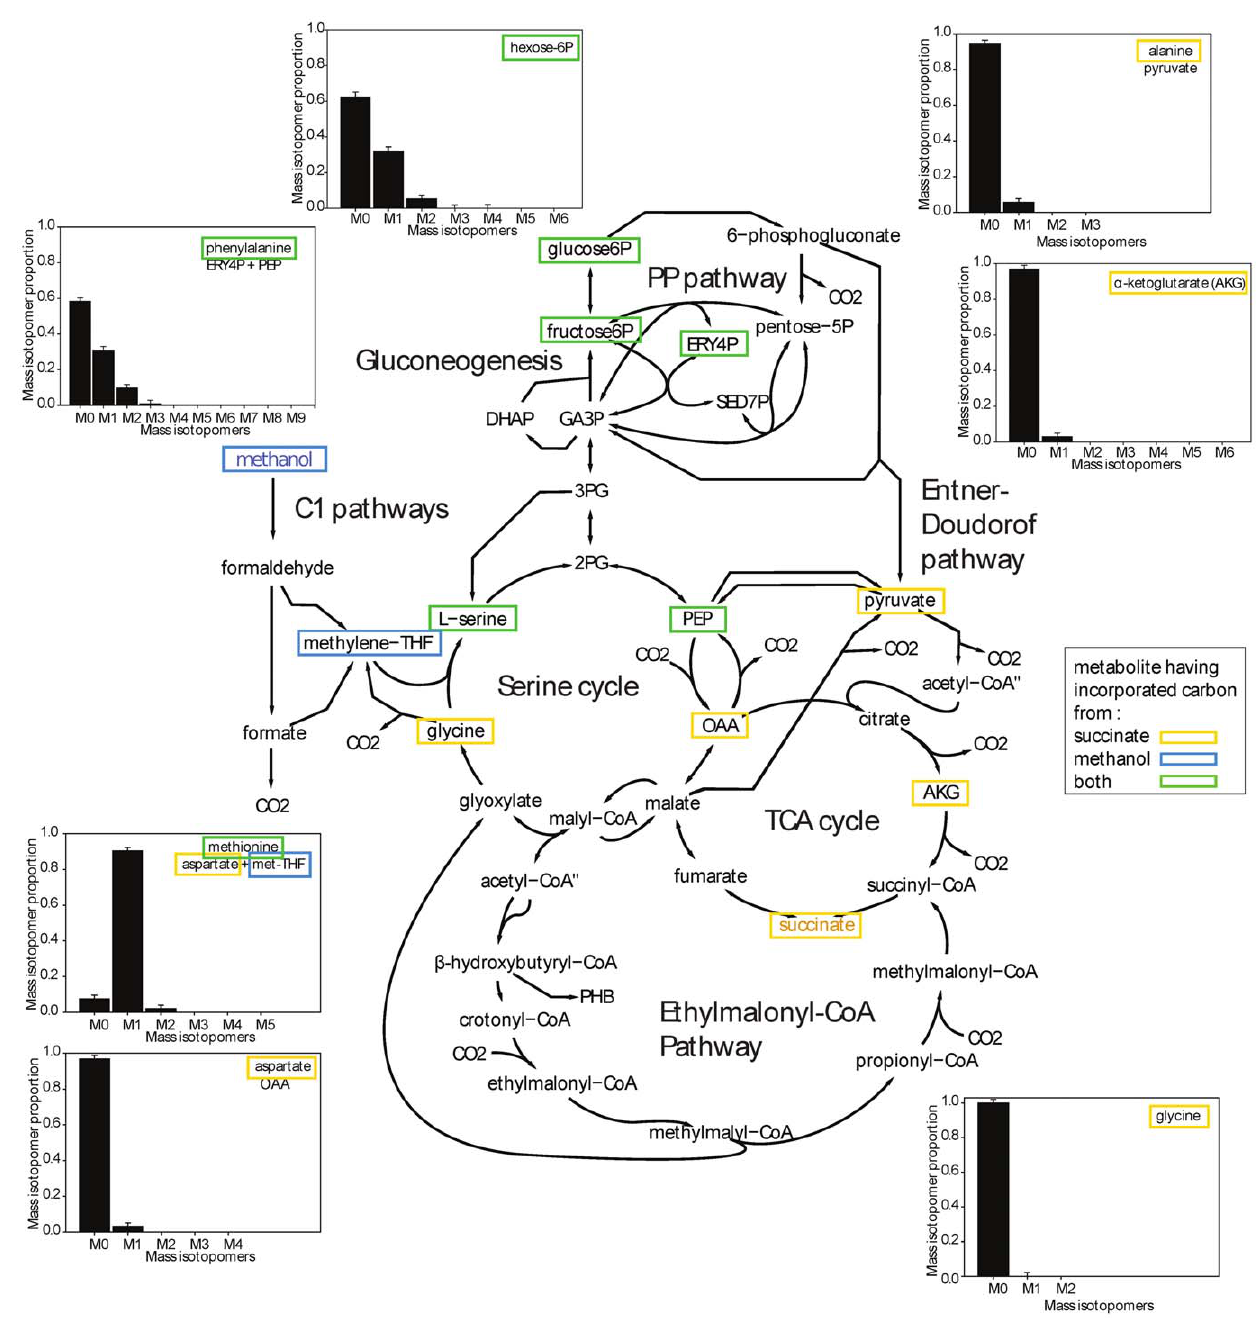
Figure 3. Central metabolic network map displaying selected mass isotopomer distributions of the central metabolites measured by LC-MS of M.extorquens AM1 growth upon co-consumption with 13 C ( . 99%) methanol and natural abundance (1.1% 13 C) succinate. The precursors of the amino acids measured in the central metabolism and directly measured metabolites are indicated in boxes. The box colors indicate substrate-specific carbon incorporation: orange from succinate, blue from methanol, green from both. Mass isotopomer data correspond to samples collected during the mid-co-consumption phase (Sampling time 1 in Figure 1).